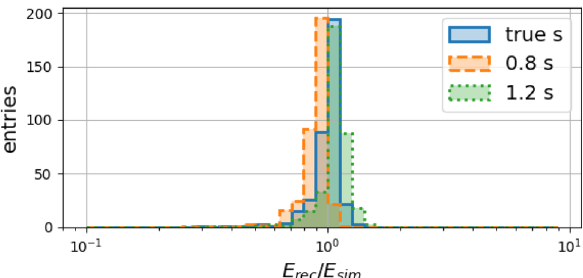
Fig. 17 The estimated shower energy according to Eq. (4), calculated for the radio signals from simulated hadronic showers using the true s parameter (blue, solid) and an s parameter that is under- (orange) or overestimated (green) by